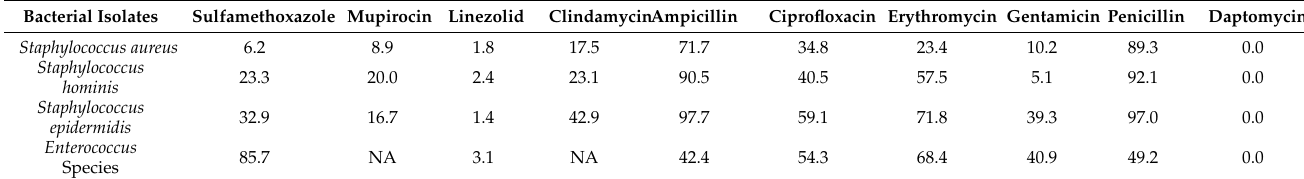
Table 8. Gram-positive bacterial resistance rates in patients aged 48–63 years.